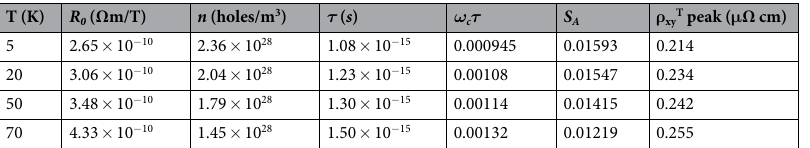
Table 1. Normal Hall coefficient ( R 0 ), effective carrier density ( n ), electron scattering time ( τ ), calculated ω c τ ( ω c the cyclotron frequency), S A corresponds to AHE coefficient due to magnetization behavior, and the T at different temperatures. τ , ω ω τ are calculated for the maximum applied field of 5 maximum value of ρ c , c xy